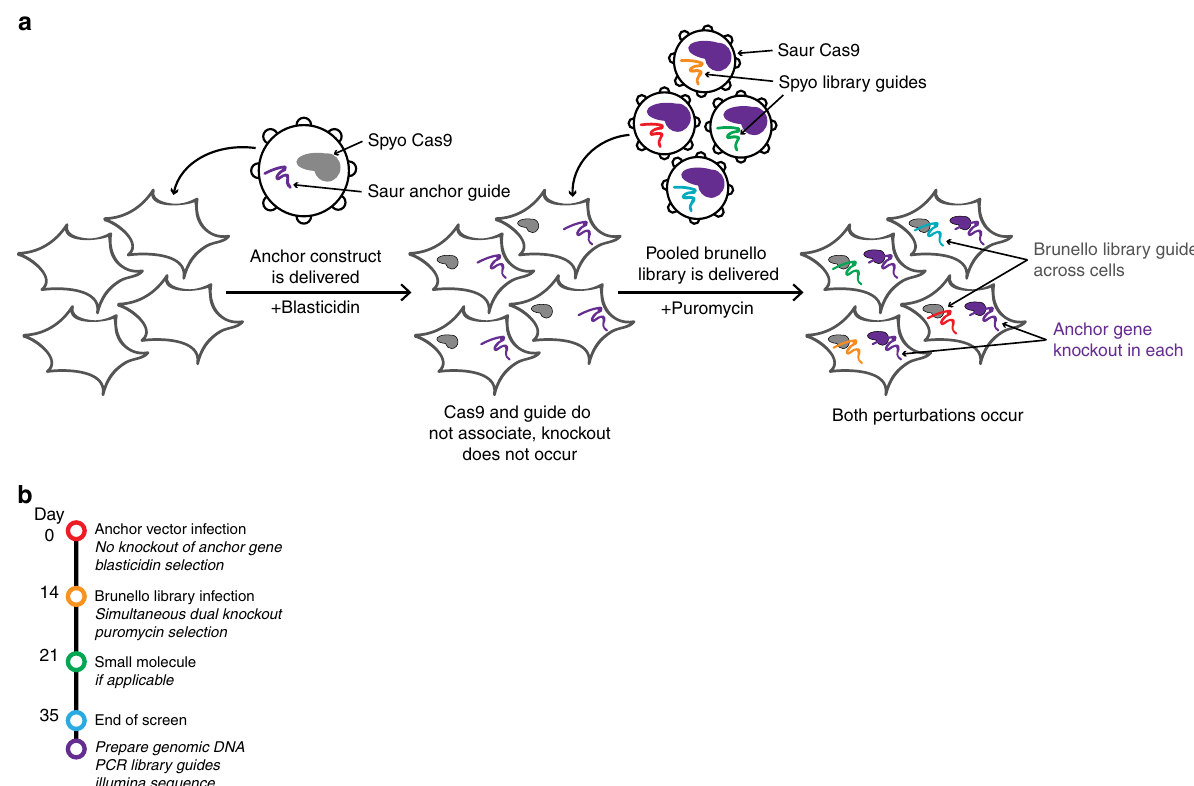
Fig. 1 Development of isogenic cell lines and the anchor screening approach using a two-Cas9 system. a Schematic of anchor screens performed with the Brunello library. Saur components in purple and Spyo in remaining colors. b Timeline by which the screens were